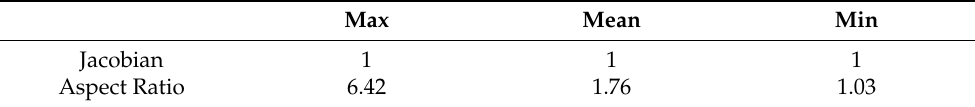
Table 2. Mesh quality parameters.